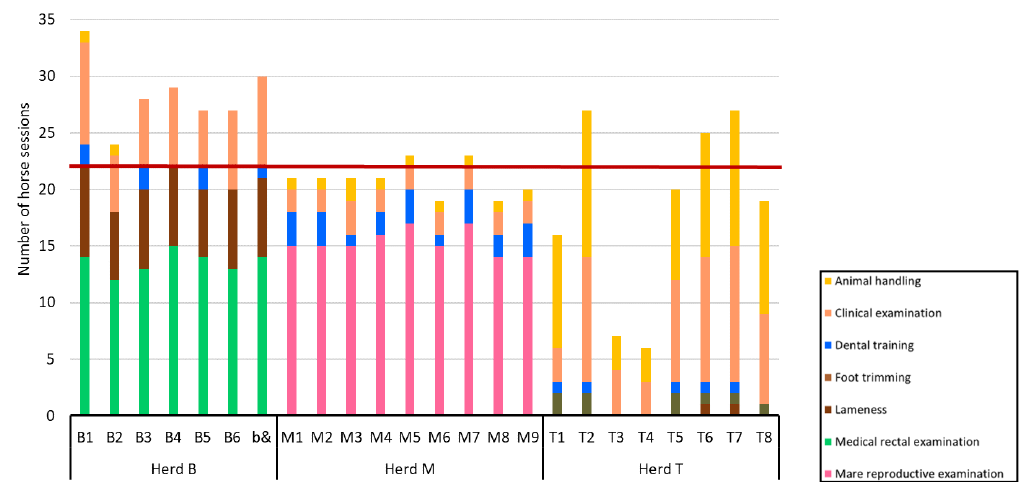
Figure 2. Individual numbers of horse sessions stratified by herd over the calendar year. The red line represents the median ( = 22) number of horse sessions of the three herds. Table 3. Characteristics of each type of practical teaching class during the 2018 calendar year. The length of the horse session and the number of students per horse are presented with the median and interquartile range